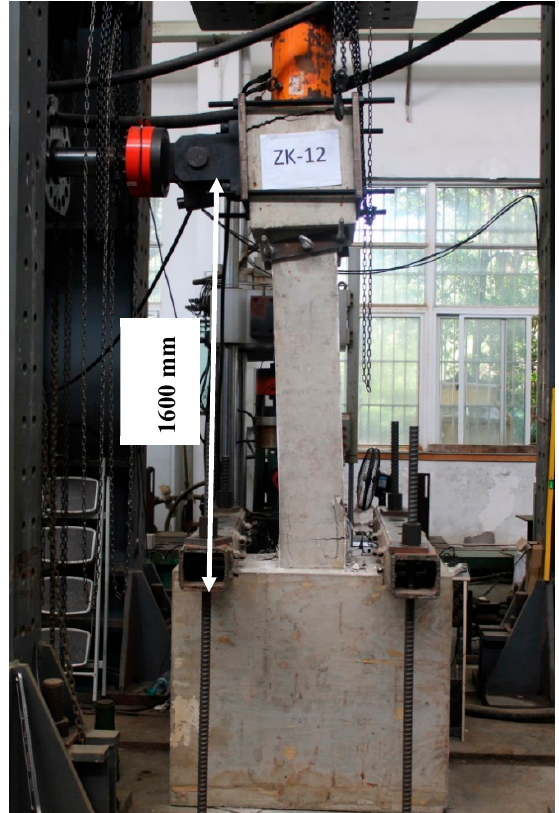
Figure 4. Picture of cyclic loading test.